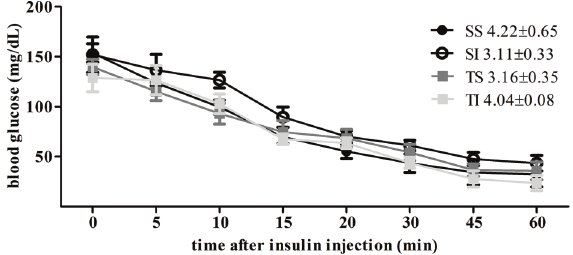
Figure 3. Blood glucose pro fi le during insulin tolerance test and rate of blood glucose decay (kITT, numerical values) of Swiss mice of groups SS: sedentary treated with saline; SI: sedentary treated with insulin; TS: trained treated with saline; and TI: trained treated with insulin. Data are reported as means ± SE for n=5 – 7/group.